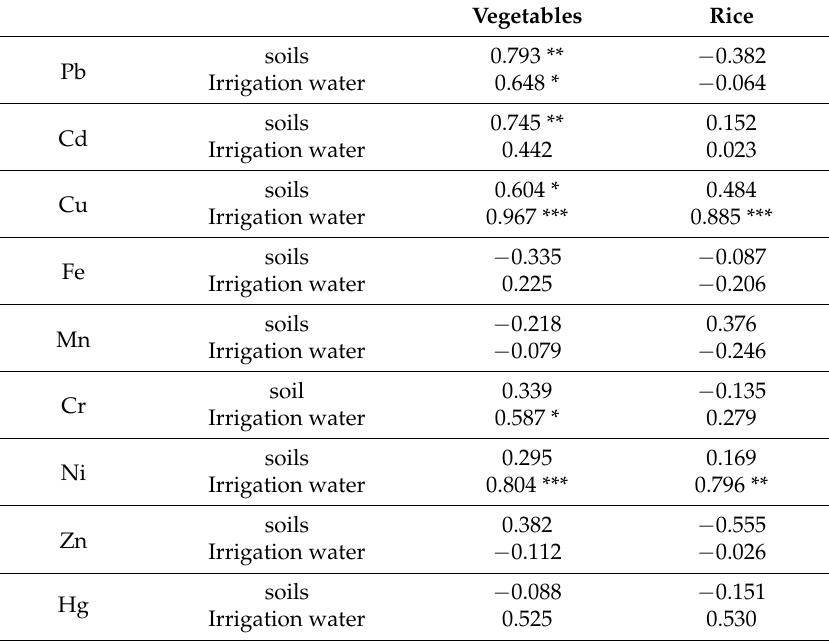
Table 7. Correlation analysis of metal concentrations among different environmental